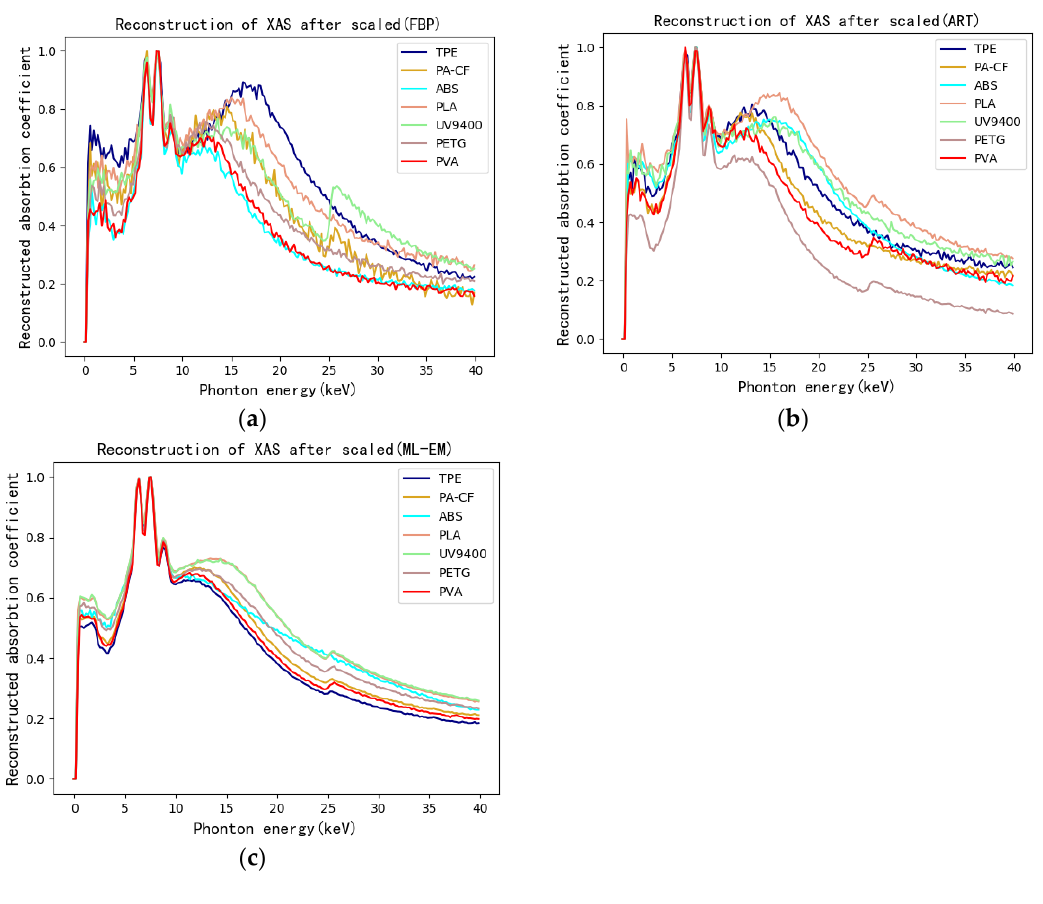
Figure 8. ( a ) Markers of each kind of samples in training-set specimen ( b ) ROI distribution of CT image by FBP.